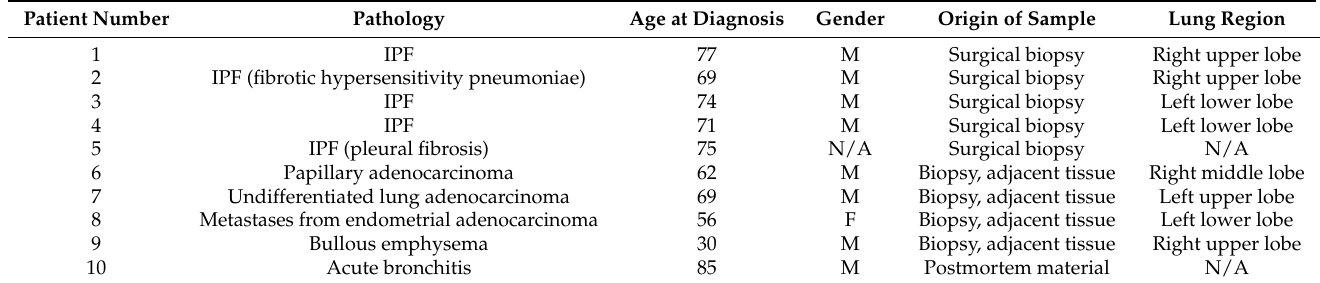
Table 2. Additional information of human lung tissue samples used in the